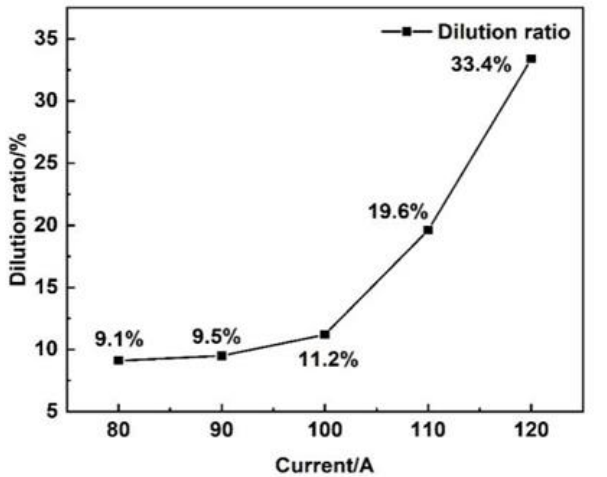
Figure 3. Variation curve on dilution ratio of 2205 DSS cladding layer under different current. Figure 4 shows the SEM results of specimens under different current. The line scanning results show that the elements migration occur at the interface of the 2205 DSS cladding layer and the substrate, which suggests an excellent metallurgical combination between them. It can be seen from Figure 4a–d that with the increase of the current, the grain size increased.